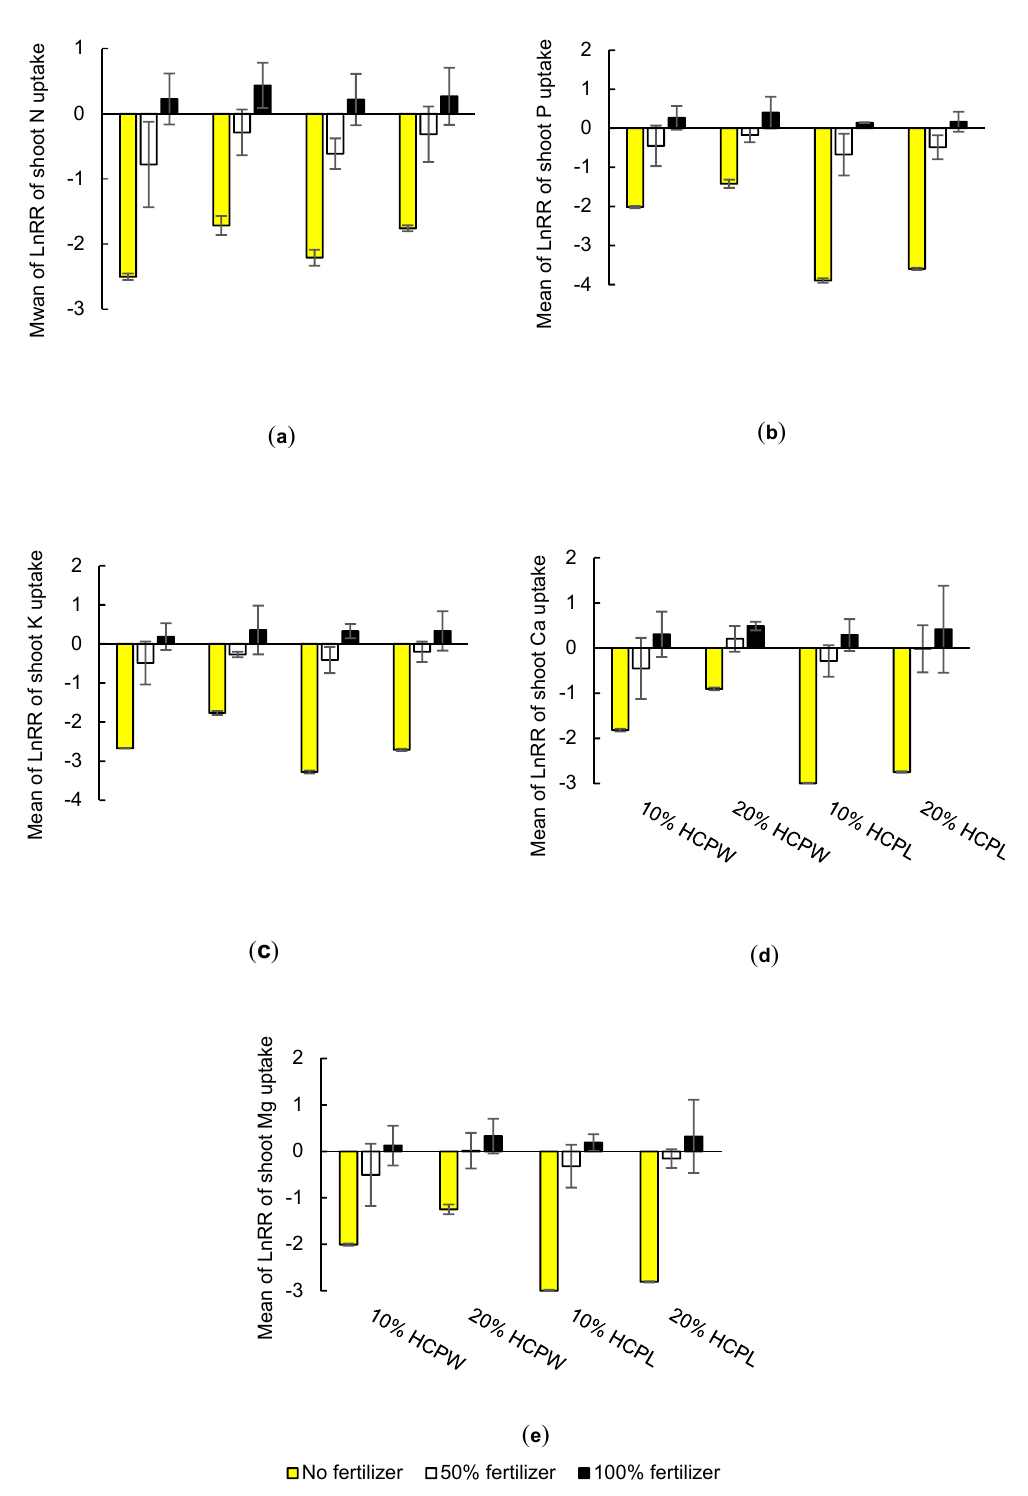
Figure 3. Mean ( ± 95 CI, n = 3) natural logarithmic response ratios (standardized with the untreated fully-fertilized control) of shoot N ( a ), P ( b ), K ( c ), Ca ( d ) and Mg ( e ) uptake of pine tree seedlings grown in peat mixed with 10% and 20% (v / v) hydrochar powder (HCPW) and hydrochar pellet (HCPL) in unfertilized (yellow bars), half (open bars) and full fertilized (black bars) conditions. Effects of hydrochar type and application rate were considered significant, relative to controls receiving 100% fertilizer, when 95% CI did not overlap with zero in each nutritional regime.